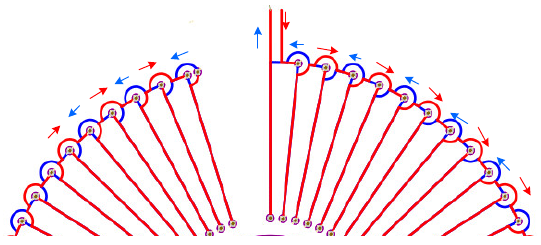
Figure 6. Enlarged view of differential winding coil structure.